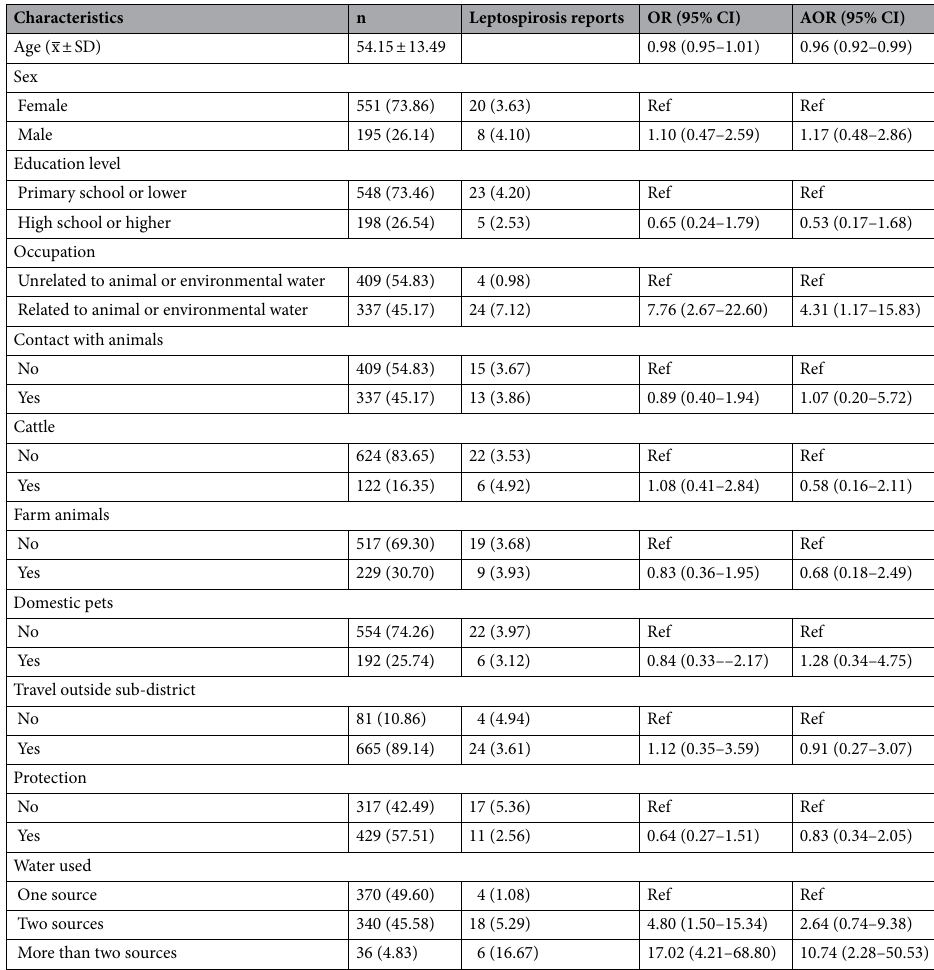
Table 3. Univariate and multivariate mixed-effects logistic regression analysis for both